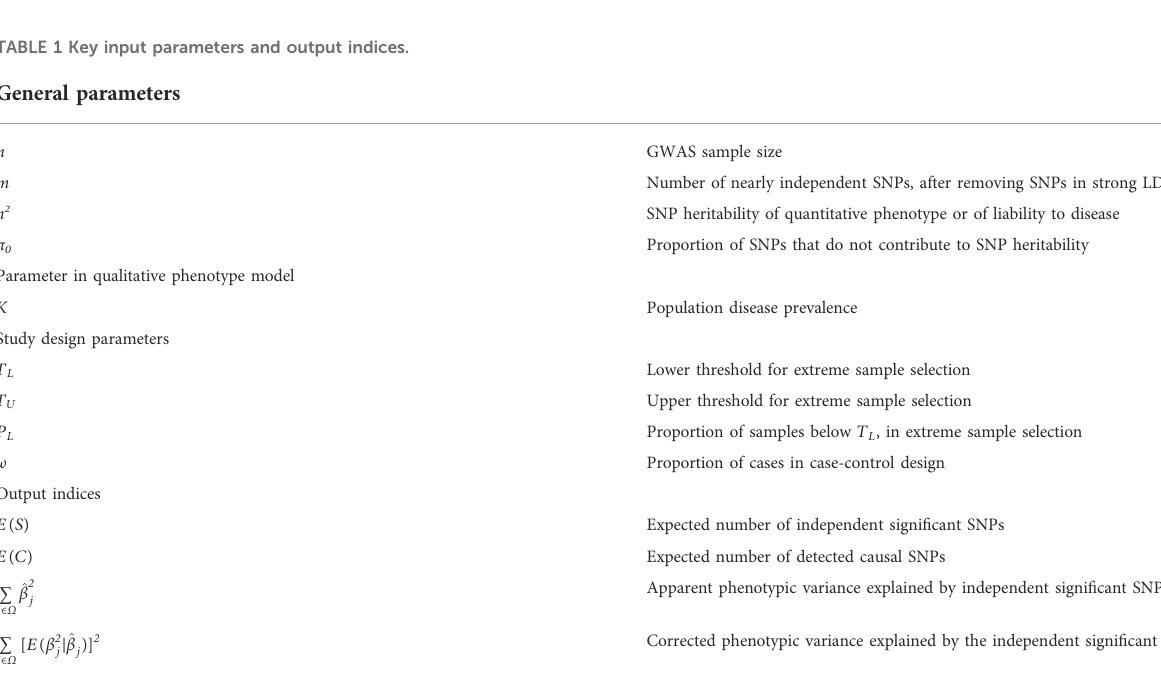
TABLE 1 Key input parameters and output